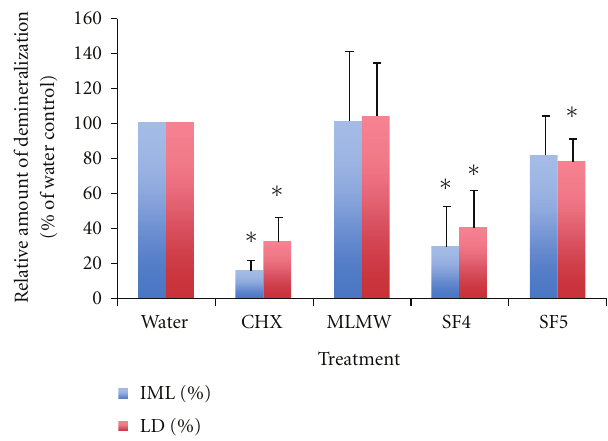
Figure 3: Average amount of demineralization (integrated mineral loss, IML, and lesion depth, LD) relative to the respective water control of each treatment (IML and LD of the water group were set to 100% to normalize the data among di ff erent CDFF runs). CHX— chlorhexidine digluconate; MLMW—mushroom low molecular weight fraction; SF4—subfraction nr 4 of MLMW fraction; SF5— subfraction nr 5 of MLMW fraction. N = 20 samples per treatment. Error bars indicate standard deviation. ∗ One sample t - test, treatment versus 100% (water control), significantly di ff erent at P < 0 .